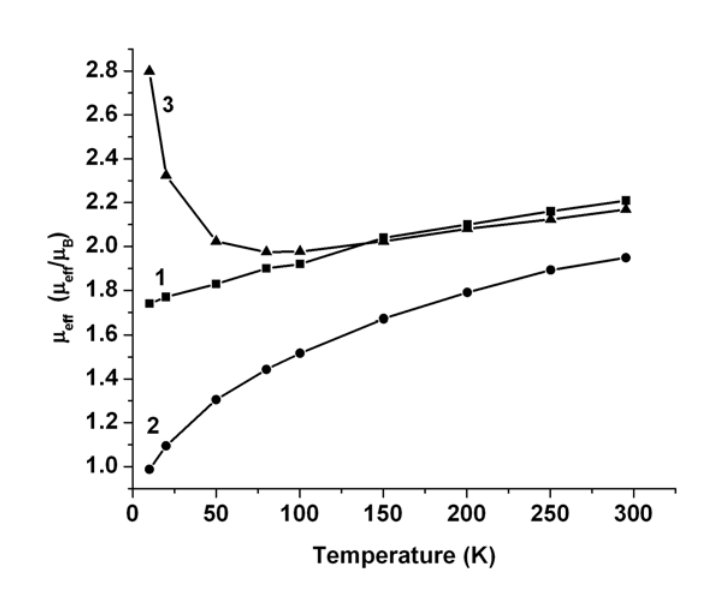
Fig. 8 Temperature dependence of the theoretical magnetic moment for tetrahedral co- ordination around Cu(II) ion (curve 1) and of the experimental μ eff , calculated at θ = K (curve 2) and at θ = -70 K (curve